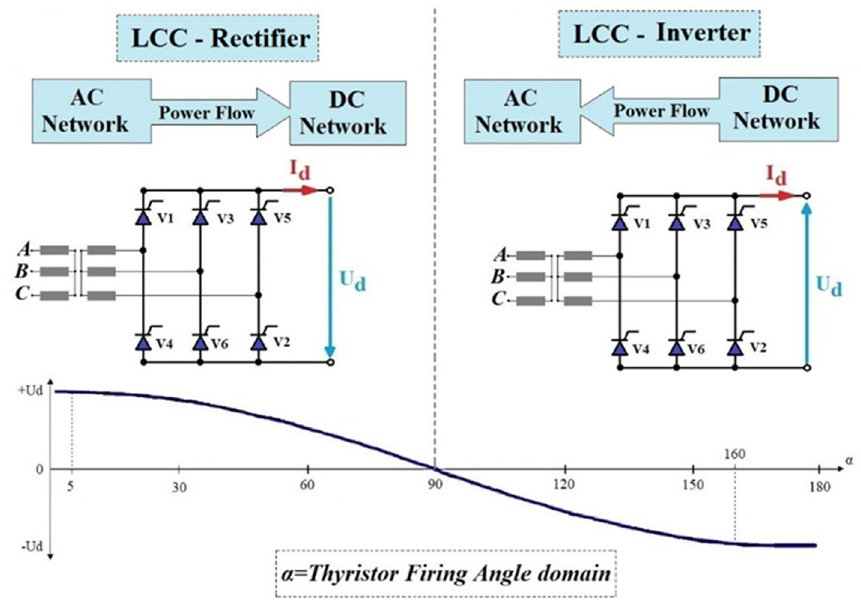
Figure 10. CSC-HVDC Converter operating modes.